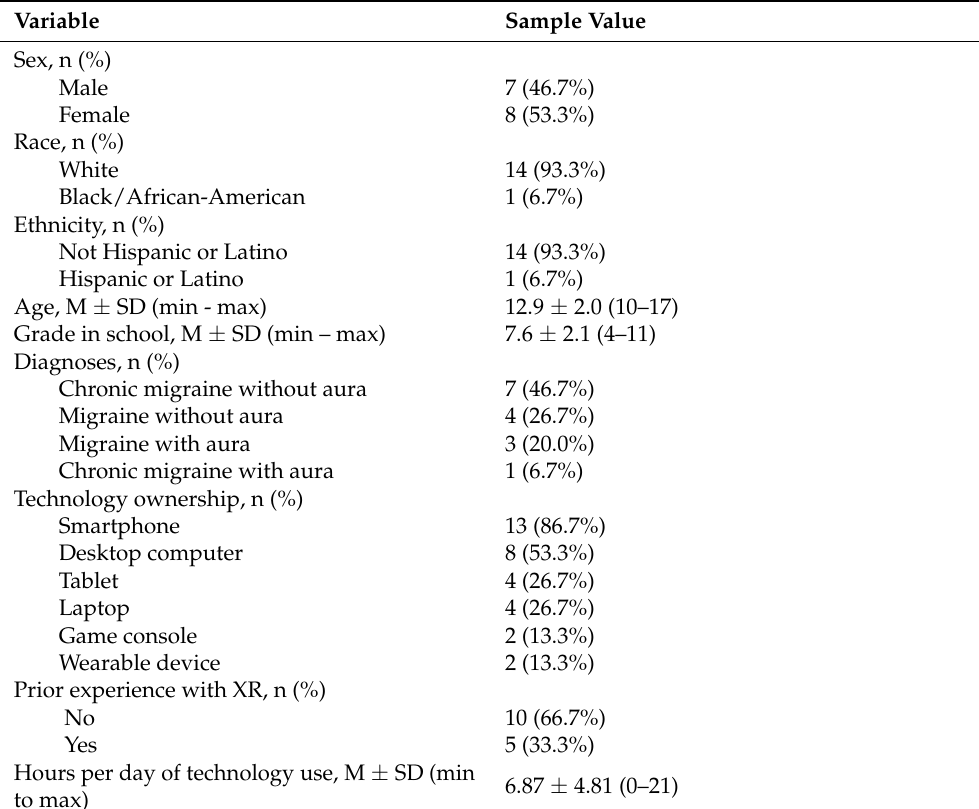
Table 2. Baseline characteristics of the enrolled